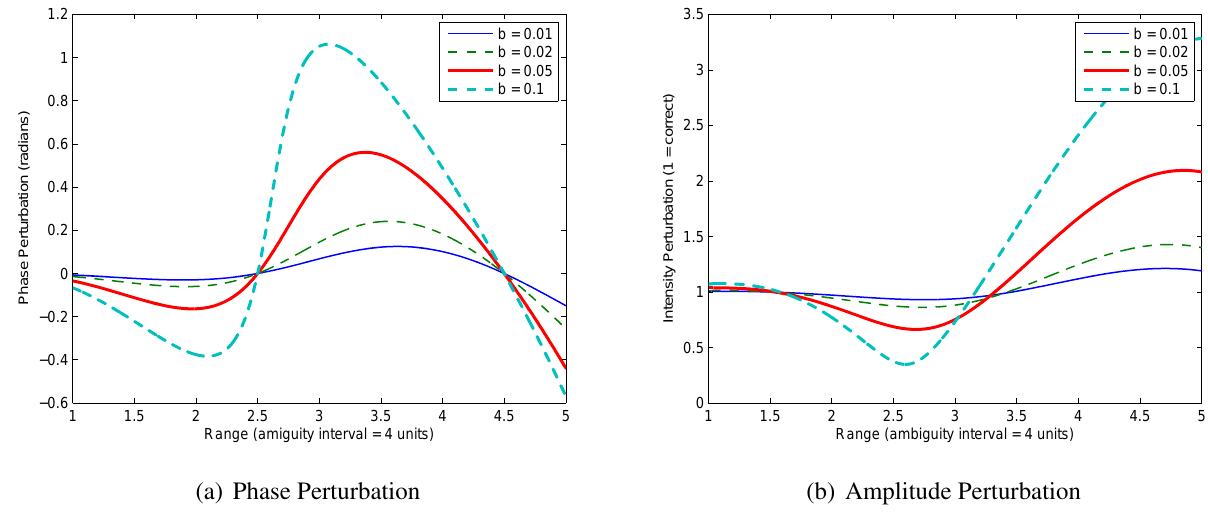
Figure 6. Simulation of the impact of scattered light on phase and amplitude